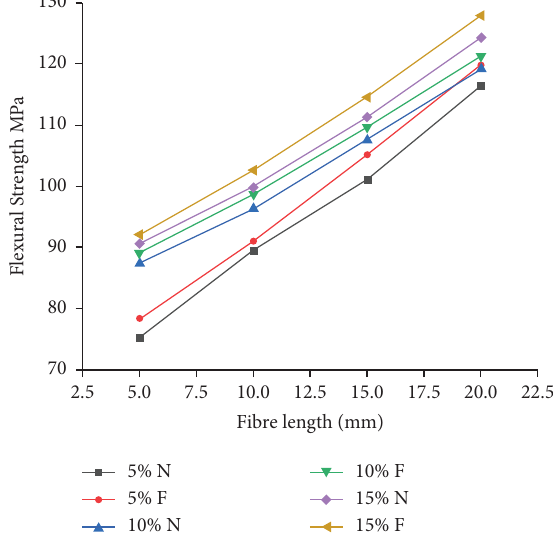
Figure 3: Tensile strength variation for diferent fbre wt.% and length (N-neat (without fller) and F (with